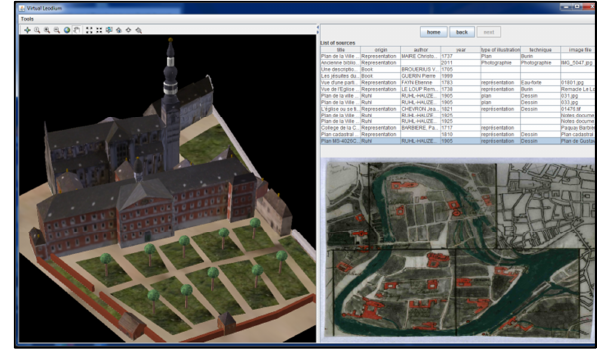
Figure 4. A snapshot of the current version of the Virtual Leodium prototype